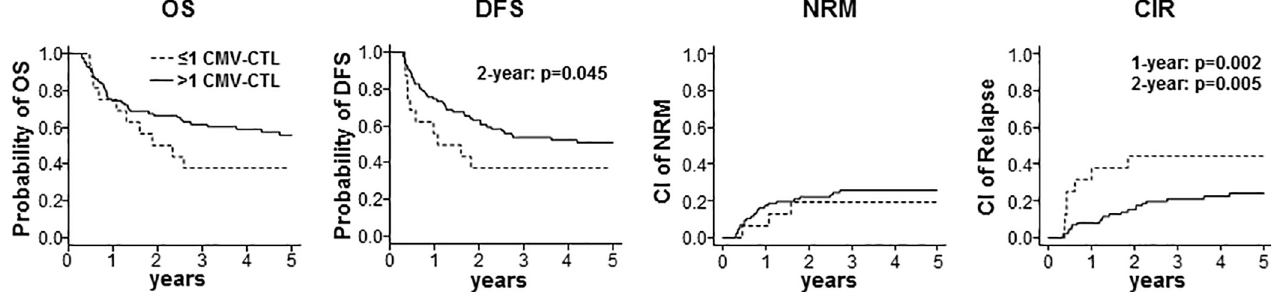
Fig 2. Presence of CMV-CTLs at 3 months after allo-SCT is associated with a reduced incidence of relapse. OS, DFS, NRM and CIR at a follow-up of 5 years are shown for all patients (n = 103) depending on the presence (black lines) or absence (dotted lines) of CMV-CTLs at 3 months after allo-SCT. Significant differences for the 2-year DFS (log-rank test) and the 1-, 2- and 5-year CIR (Gray’s test) between patients with CMV-CTLs and those without are indicated. Abbreviations: CI, cumulative